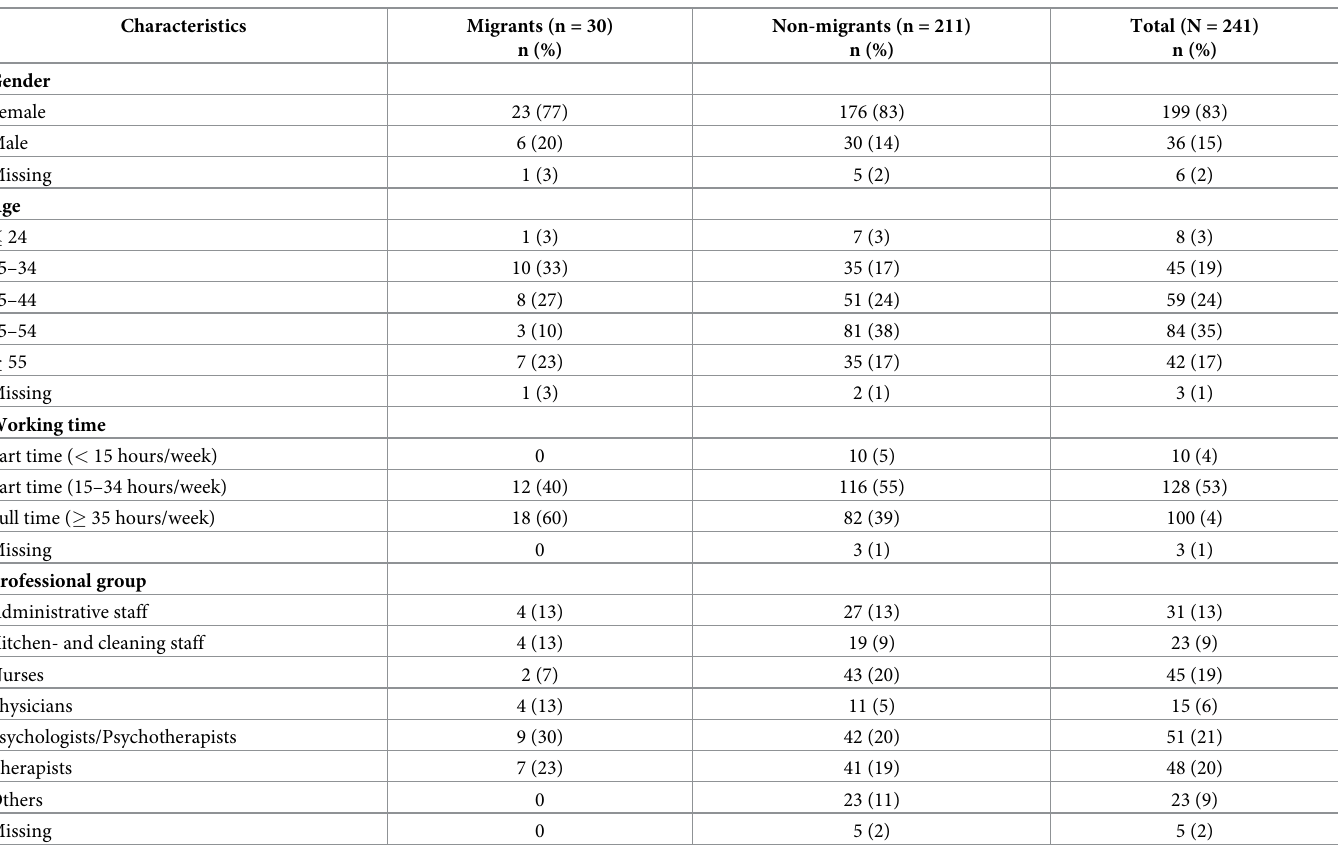
Table 1. Sample characteristics stratified by migrants (N = 30) and non-migrants (N = 211).